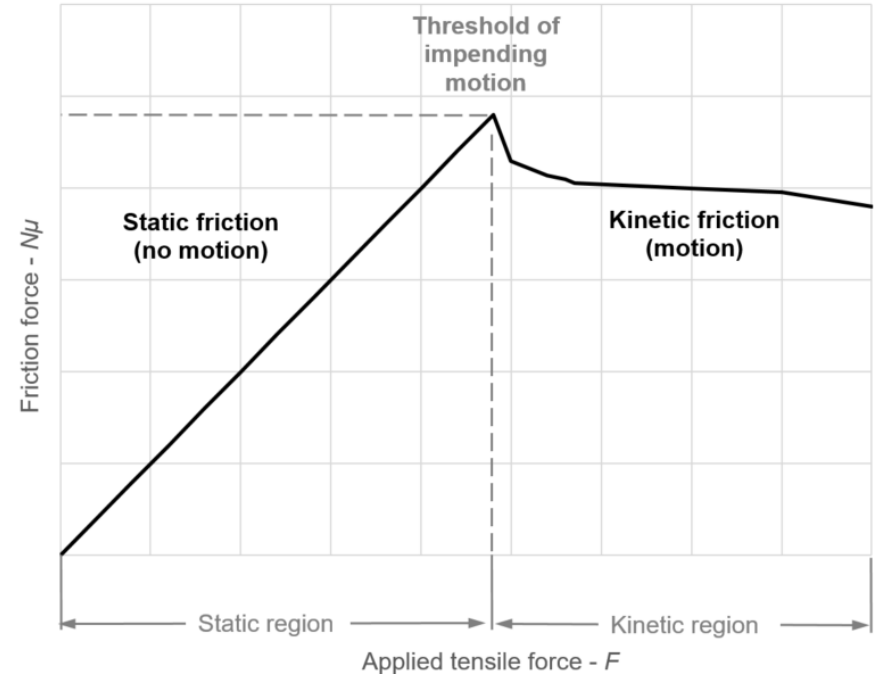
Figure 3. The indicative graphed output of a static friction test. Within the discipline of statics, the coefficient of friction ( µ ) is a dimensionless ratio, given by Equation (1), of the force required to move an object from a state of rest ( F ) and its Normal force ( N )